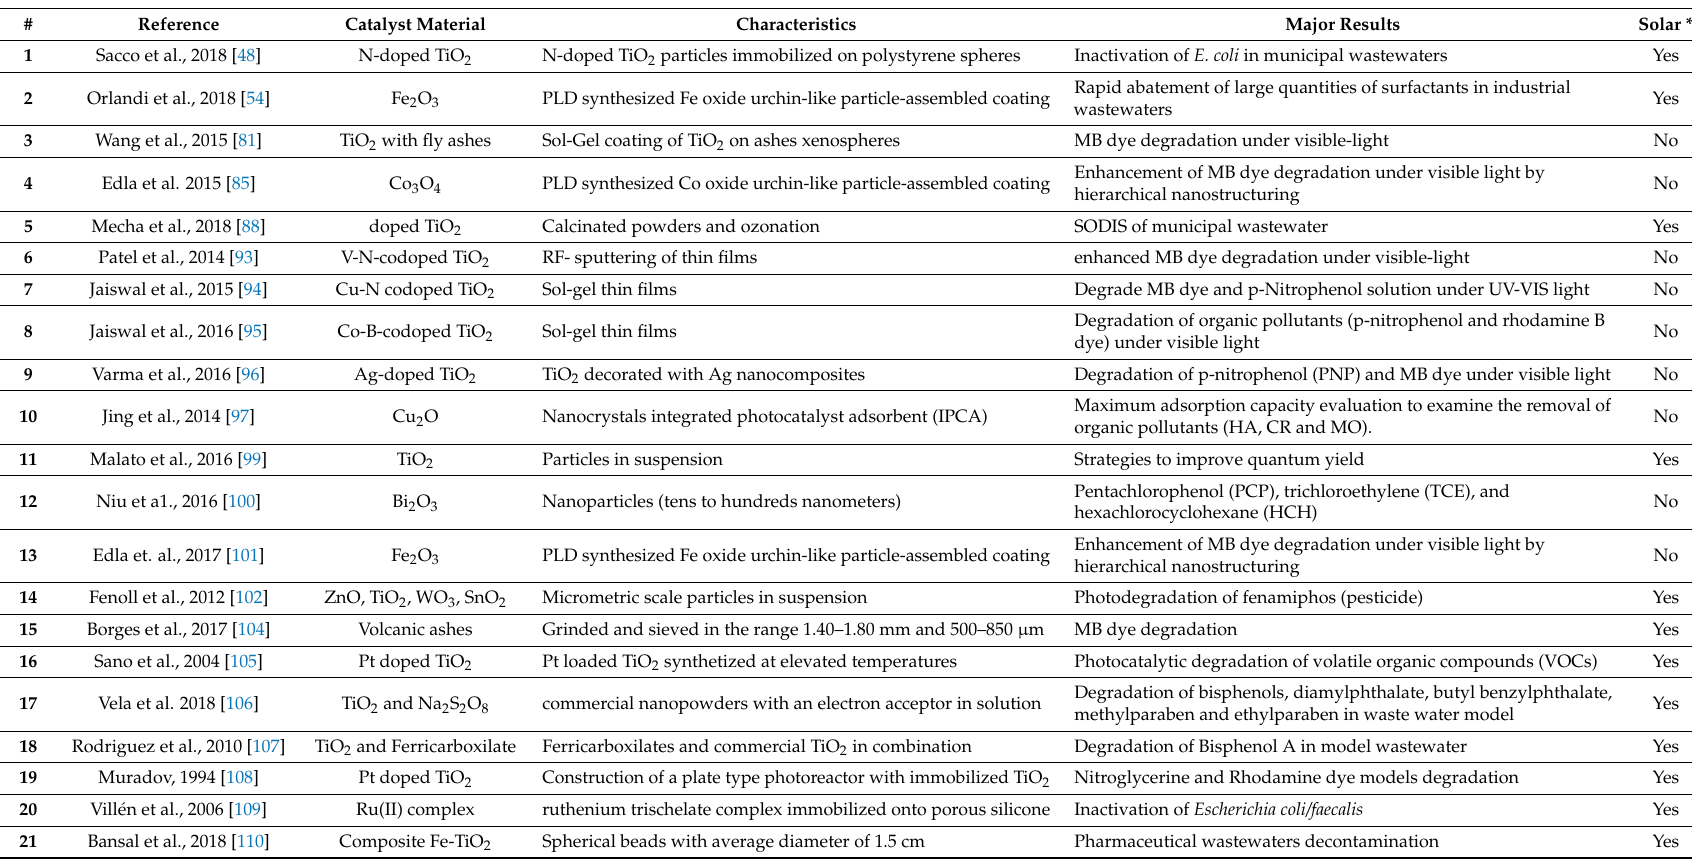
Table 2. Selected references for catalyst materials. Selection is based on two criteria: materials developed for visible light absorption and materials introducing an advancement over benchmark TiO 2